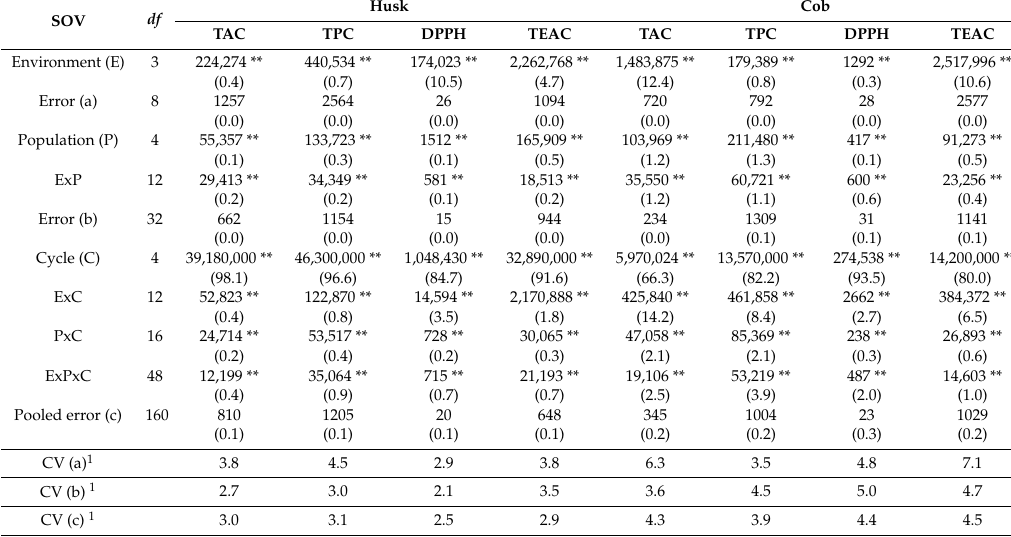
Table 4. Mean squares for total anthocyanin content (TAC), total phenolic content (TPC) and antioxidant activity determined by the DPPH and the TEAC methods of five populations and five cycles evaluated across four